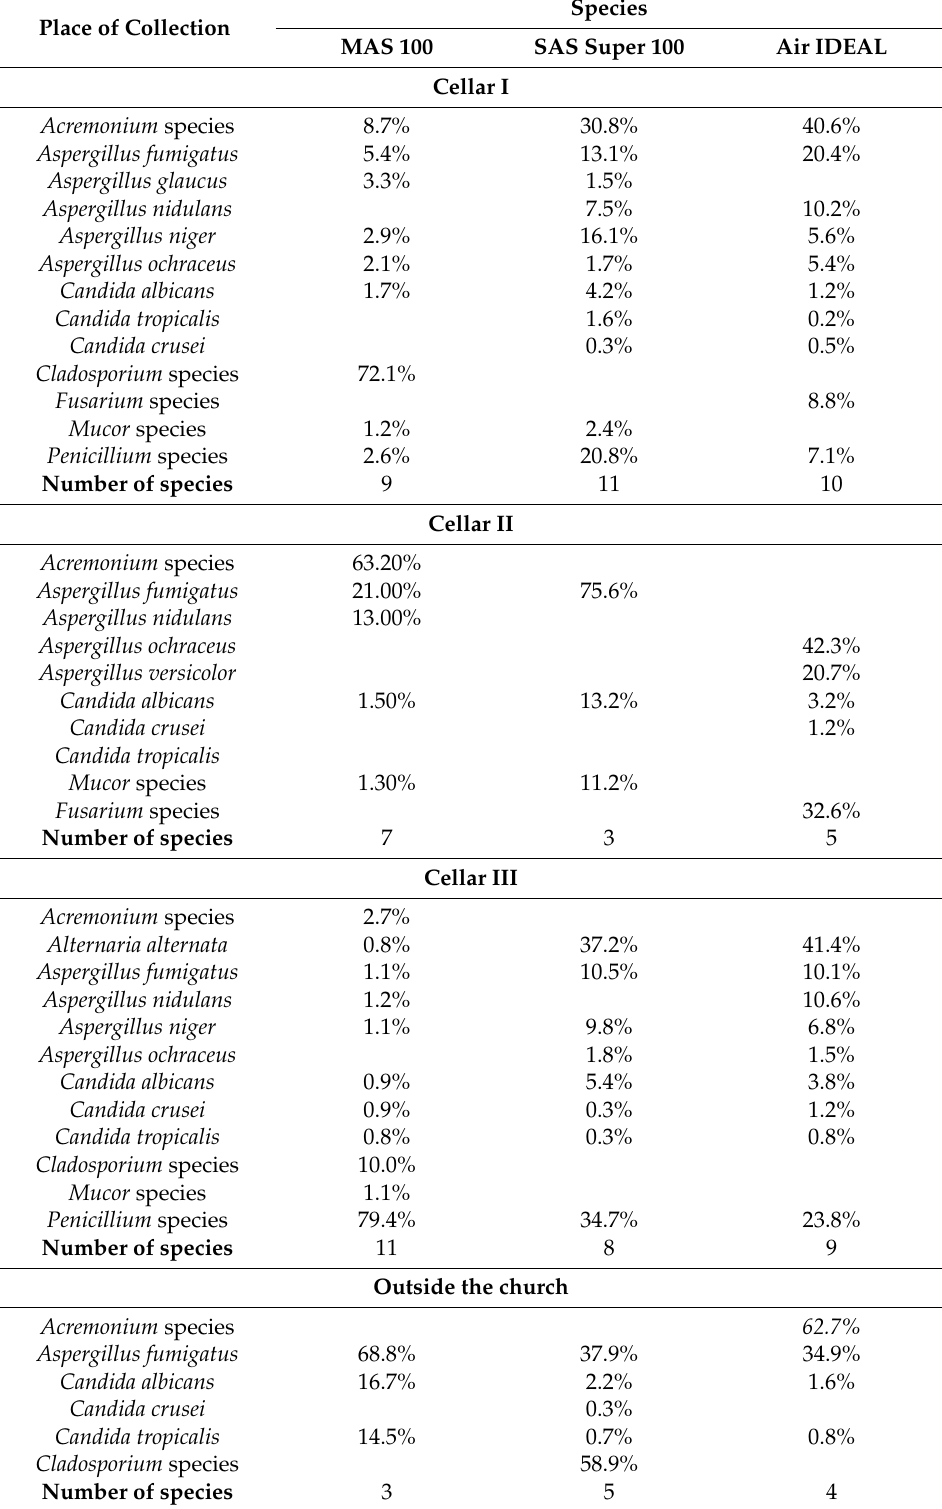
Table 3. Number of fungi species in air samples collected inside and outside the